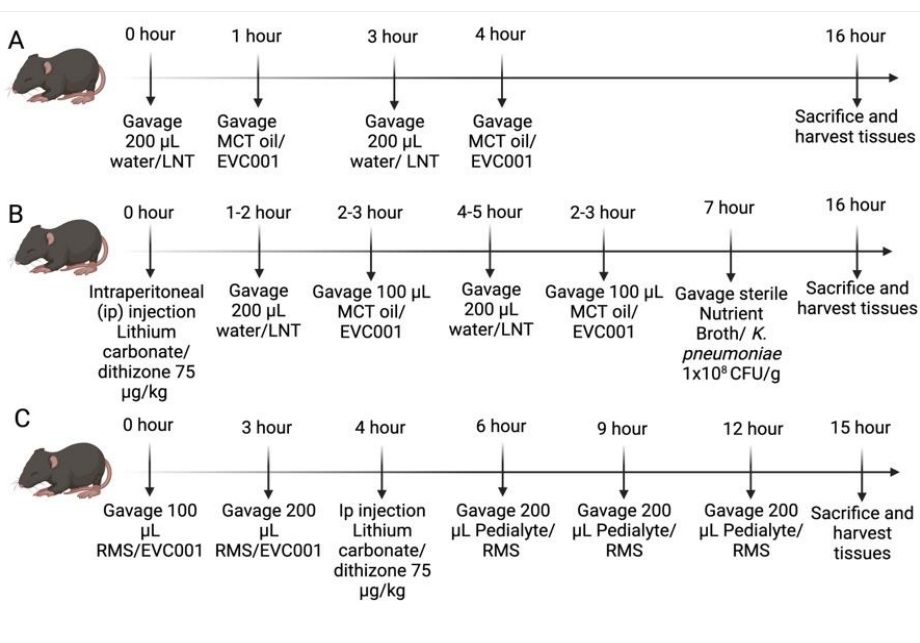
Figure 1. Model schematic. ( A ) Timeline for dosing optimization trials with Lacto-N-Tetraose (LNT) and EVC001. ( B ) Timeline for the Paneth cell disruption with bacterial dysbiosis NEC model as well as the incorporation of the dosing scheme for LNT and EVC001. ( C ) Timeline for the RMS NEC model with the incorporation of EVC001 dosing. RMS, Rodent Milk Substitute.